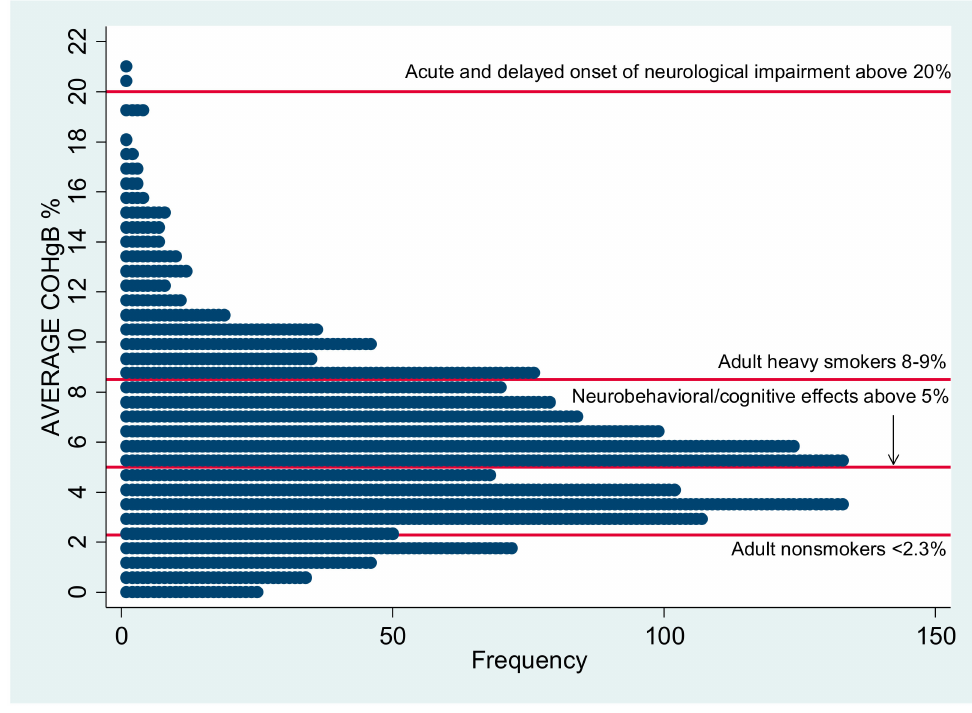
Figure 4. Dotplot showing frequency of participant average COHgB% in relation to ATSDR reference levels. Reference values: Agency for Toxic Substances and Disease Registry